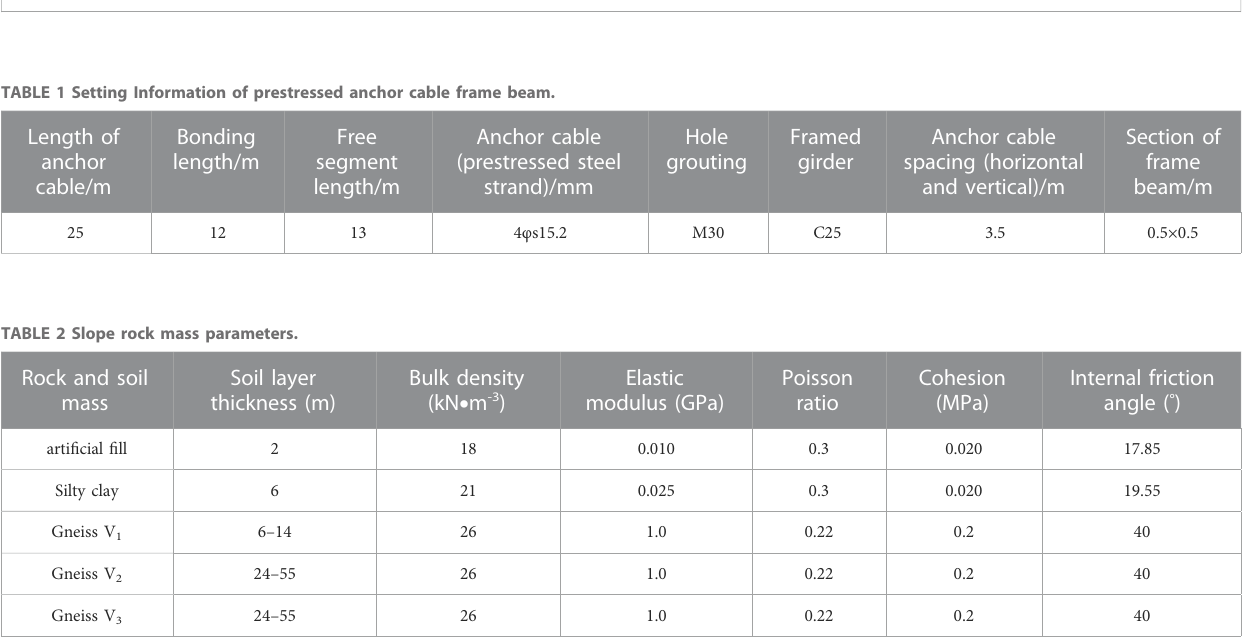
FIGURE 1 Schematic diagram of slope protection.